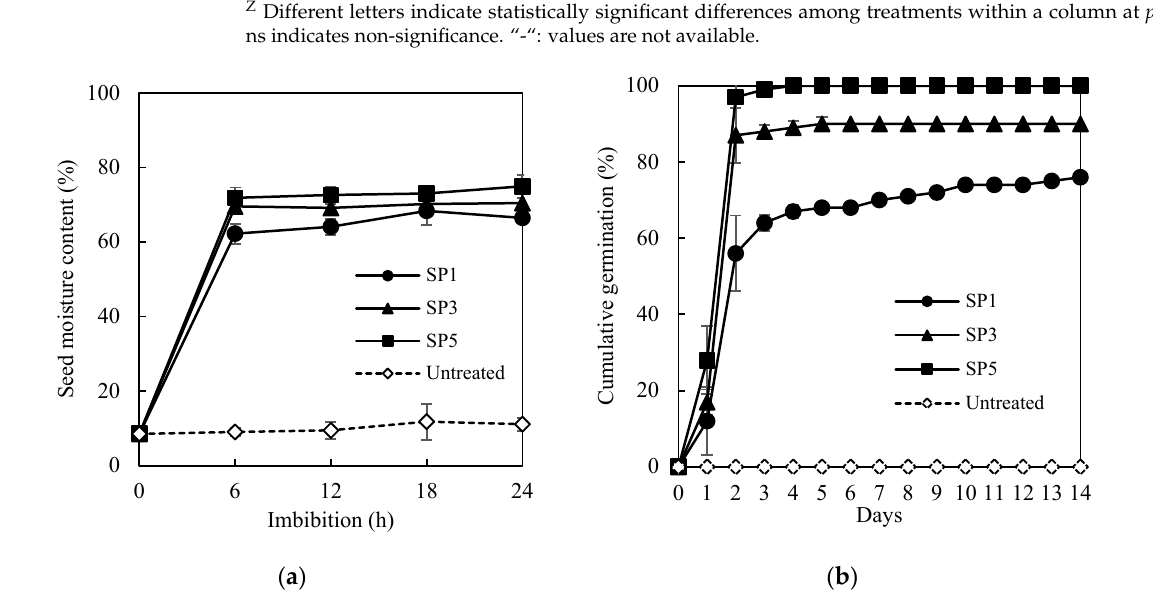
Table 1. E ff ects of 95% H 2 SO 4 , 37% HCl, and hot water (70 °C) treatment on the germination per- centage (GP), mean germination time (MGT), germination rate (GR), germination uniformity (GU), and healthy seedlings percentage (HS) of A. sikokianus seeds.